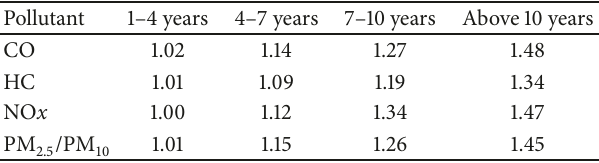
Table 8: Gasoline vehicle deterioration correction